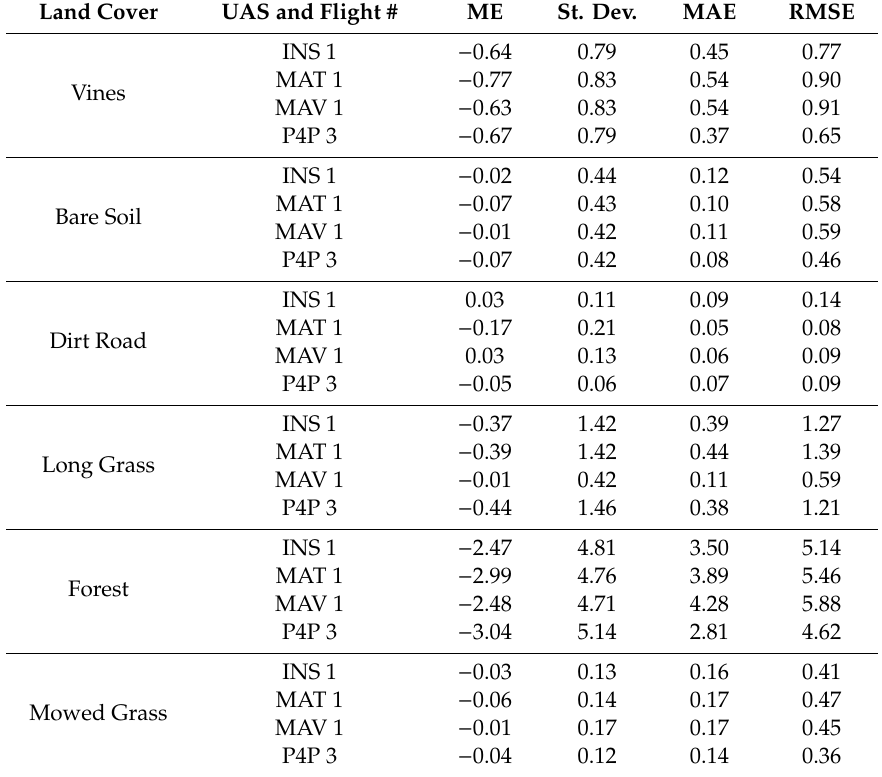
Land Cover UAS and Flight # ME St.